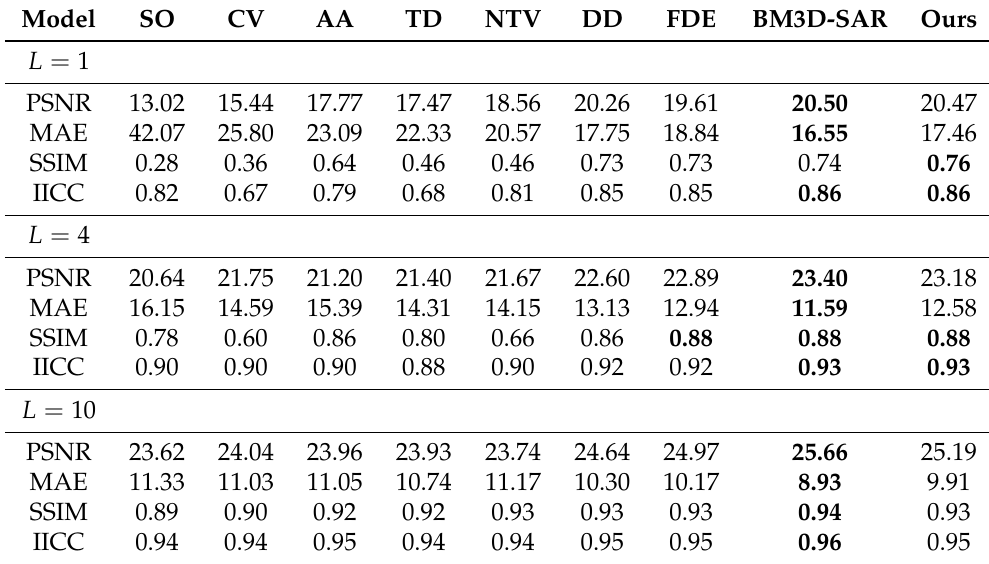
Table 5. Quantitative comparison of the different models for the satellite1 image.